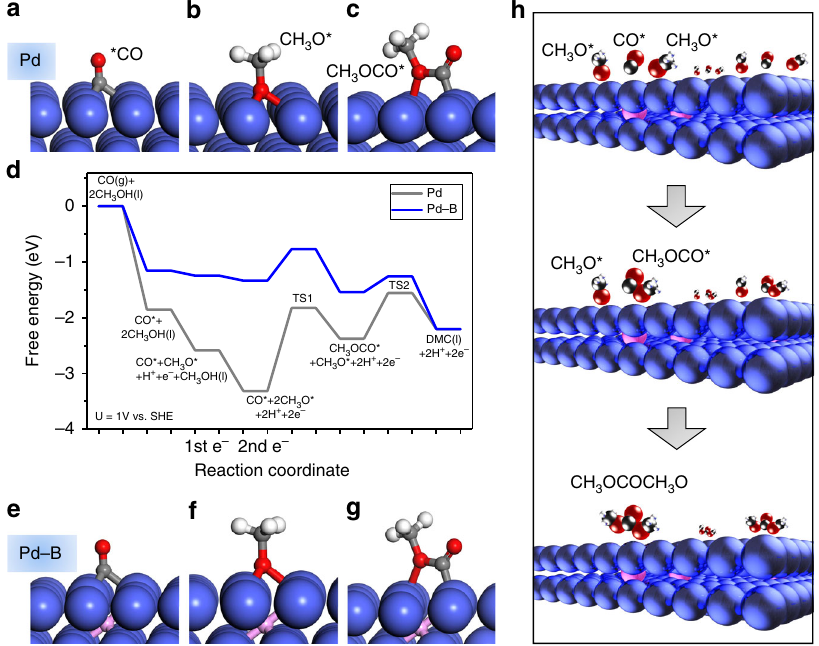
Fig. 1 DFT calculations on DMC formation. Geometries of intermediates in DMC formation reactions: a CO, b CH 3 O, c CH 3 OCO on pure Pd; e CO, f CH 3 O, g CH 3 OCO on boron-doped Pd (Pd – B). d Free energy pro fi les of DMC formation from CO and CH 3 OH on pure Pd (gray) and Pd – B (blue) at U = 1 V vs. SHE. h Reaction scheme for electroproduction of DMC from methanol and CO on the Pd – B electrode. DMC/CH 3 OCOCH 3 O: dimethyl carbonate. Red, gray, white, pink, and blue balls represent oxygen, carbon, hydrogen, boron, and palladium,